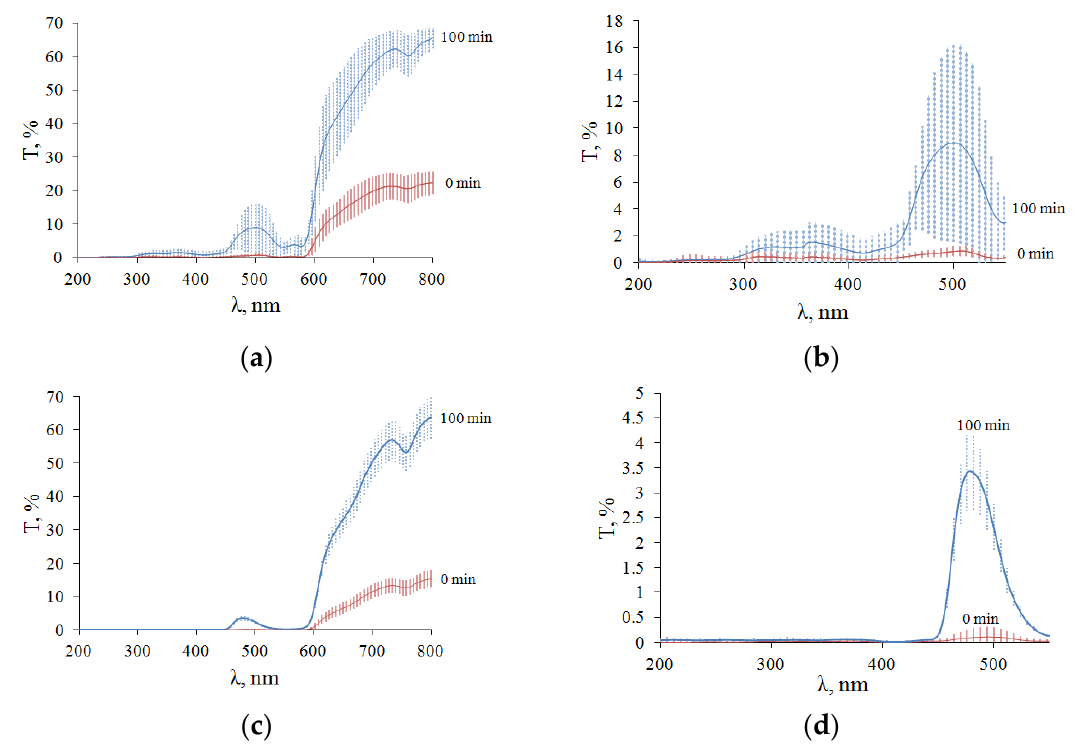
Figure 11. Averaged TTS of 5 samples of cat ovarian tissue sections when immersed in 99.5% glycerol: ( a , b ) F-ph; ( c , d ) L-ph.